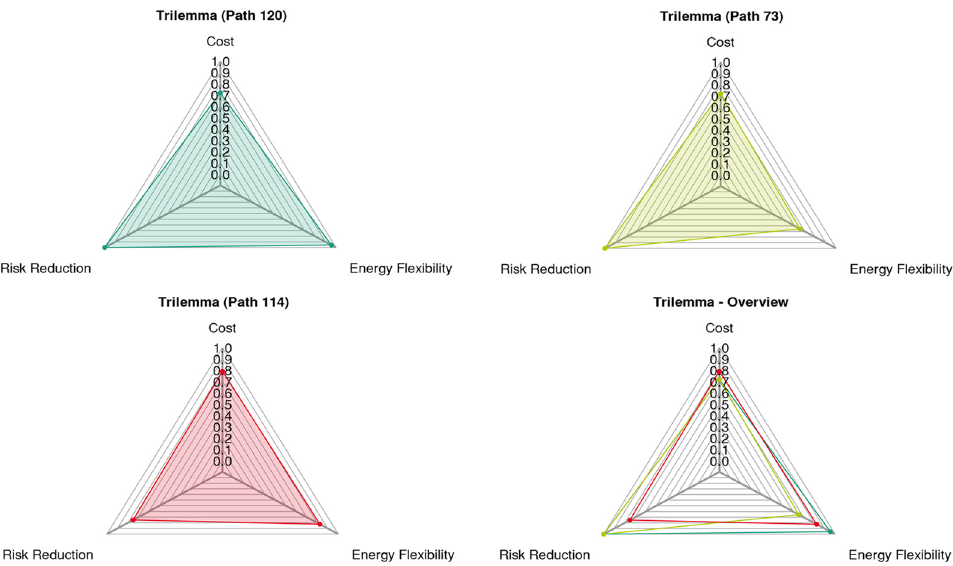
Figure 6. Trilemma of three risk treatment paths including an overview.